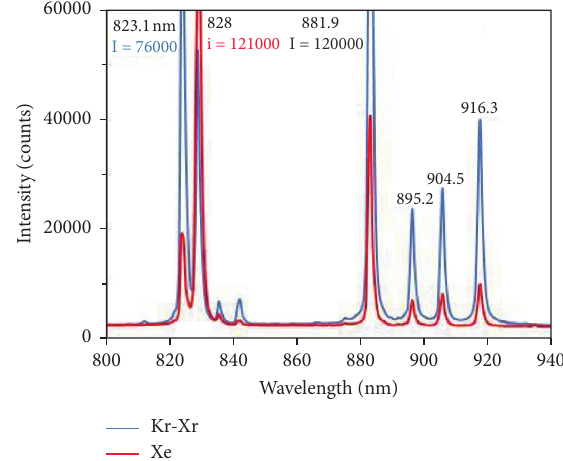
Figure 2: Emission spectra of xenon (36kPa) and Kr-Xe mixture at a temperature of 413K F � 10 14 n/cm 2 s. Spectrometer integration time: 300 ms (Kr-Xe), 75ms